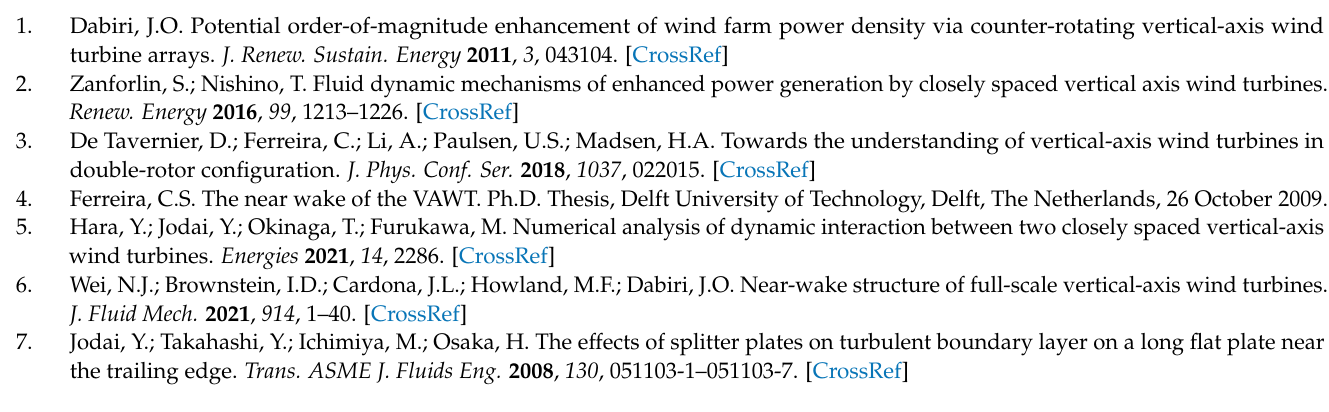
Figure A2. Experimental setup of the torque measurements and the wind tunnel at Tottori University: ( a ) a miniature wind turbine model; ( b ) a direct current motor with no current.